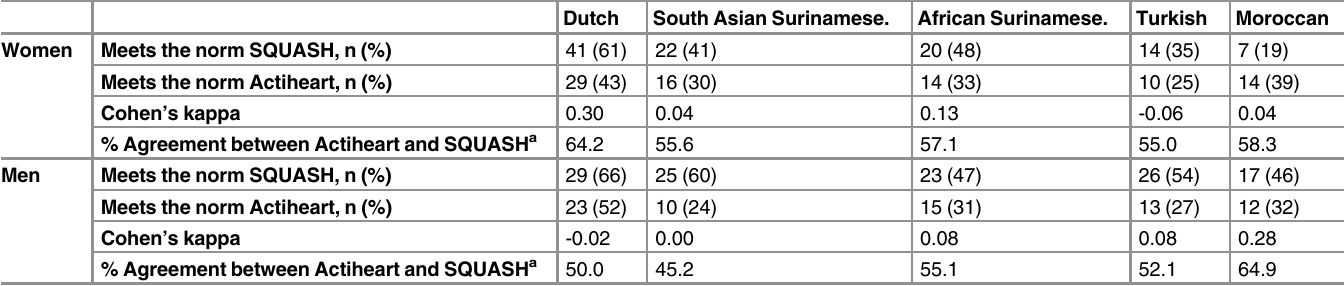
Table 5. Categorization of participants on the basis of the Dutch norm for PA (NNGB). Dutch South Asian Surinamese. African Surinamese. Turkish